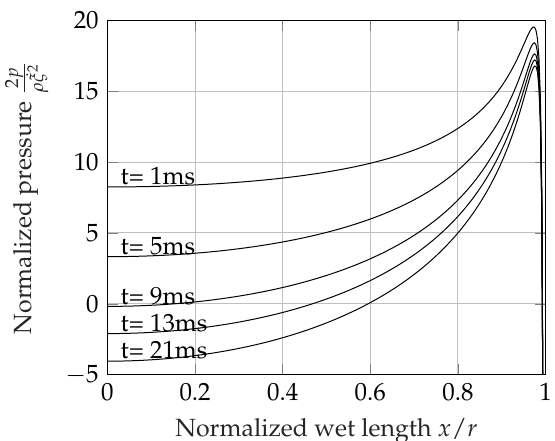
Figure 1. Sketch of the problem of the water entry of a rigid wedge. The wedge enters the water surface at t = 0 (left) and penetrates the water by an entry depth x as time advances (right).